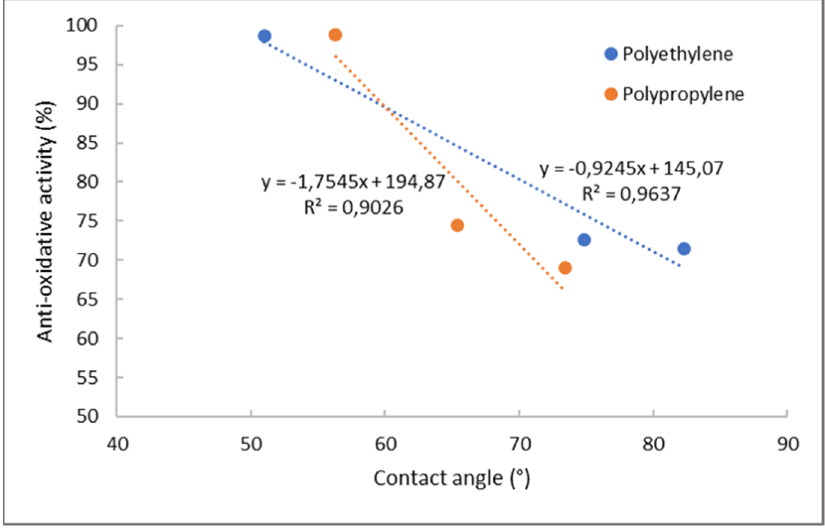
Figure 9. Correlation between contact angle and antioxidative activity for PE and PP foils.